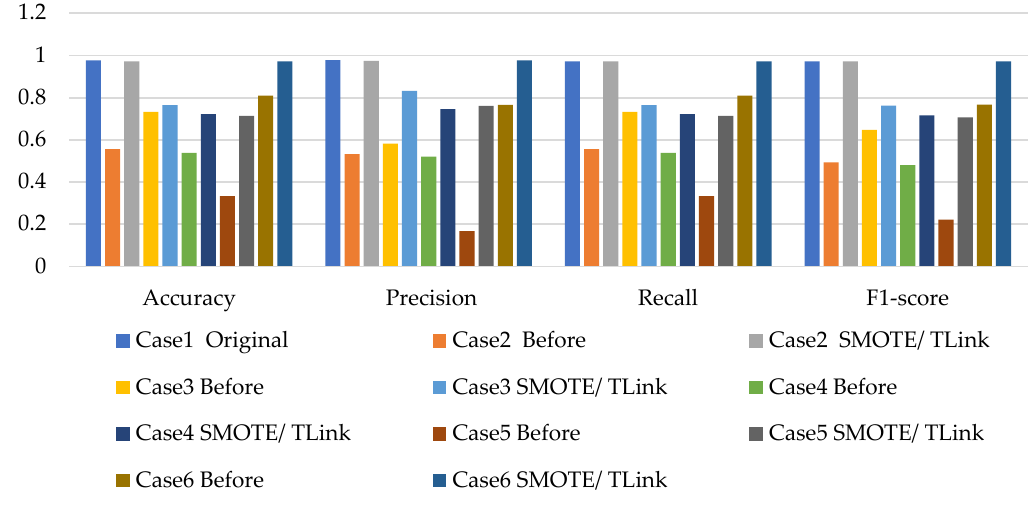
Figure 22. Experimental performance of k-NN classification with SMOTE/T-link.